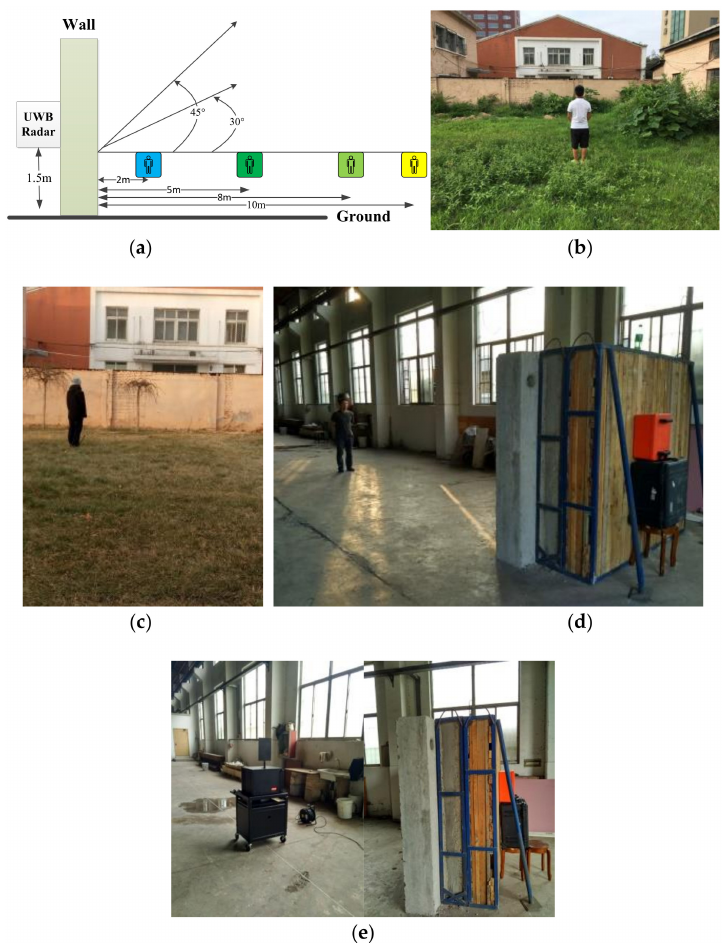
Figure 11. The experimental setup for data acquisition, ( a ) the experiment model, ( b ) through-wall detection outdoors,( c )theazimuthangleexperiment,( d )through-walldetectionindoors,and( e